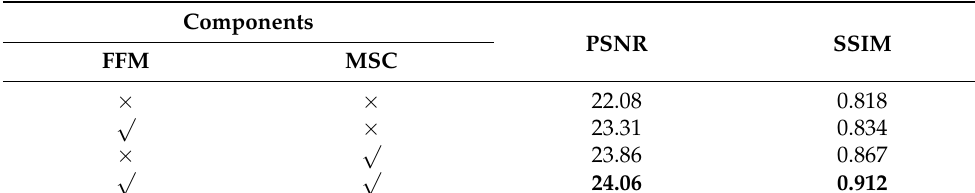
√ indicates the presence of a